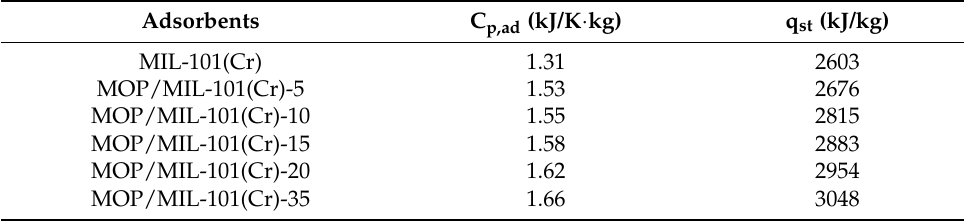
Table 1. Heat capacity (C p,ad ) and heat of adsorption (q st ) of MOP/MIL-101(Cr).